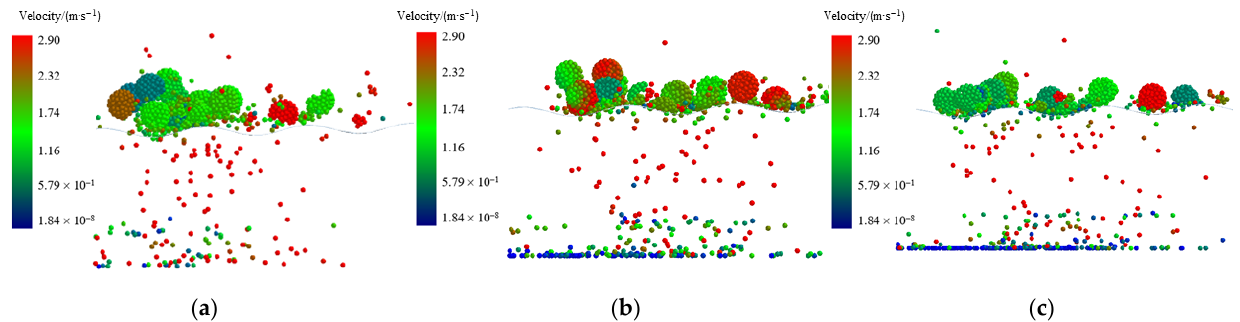
Figure 10. Velocity graph of frass agglomerates at an amplitude of 0.01 m. ( a ) t = 1.8 s. ( b ) t = 2.2 s. ( c ) t = 2.6 s.